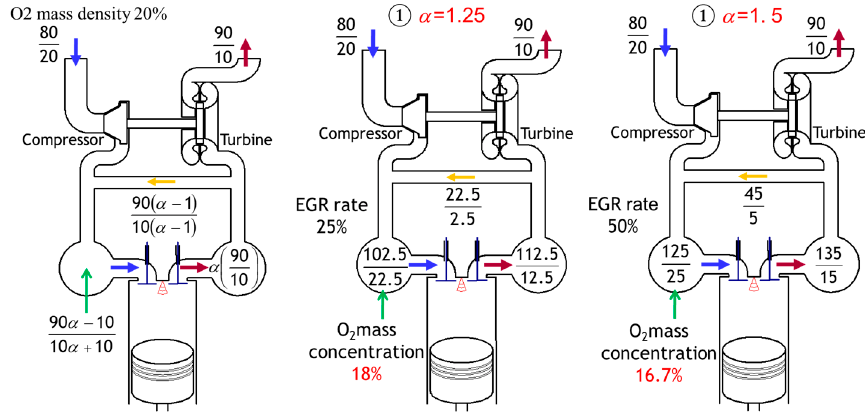
Figure 2. Mass balance of a diesel engine with EGR in the CAS case.